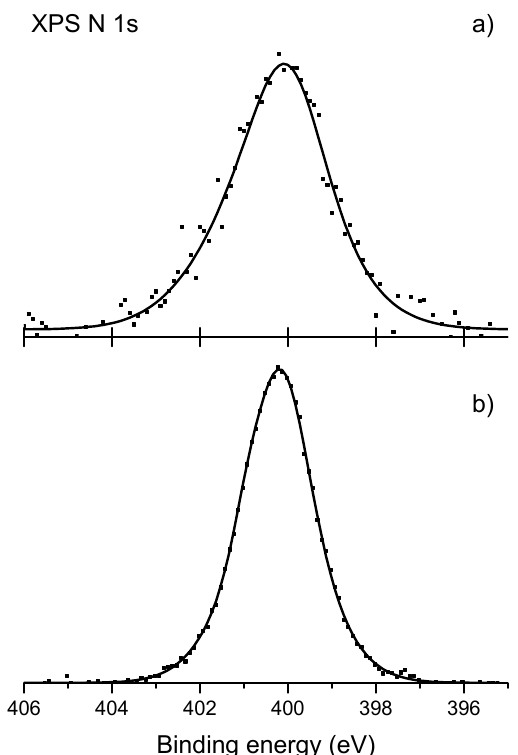
Figure 4. N 1s spectra of silica ‐ lignin + lipase product after immobilization ( a ), and pure lipase ( b ).